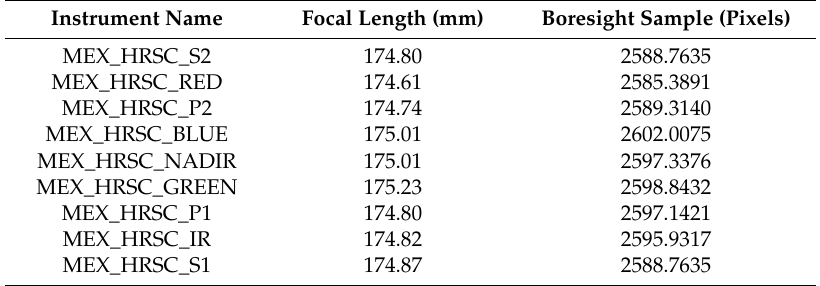
Table 1. The calibrated camera geometric parameters for HRSC. MEX: Mars